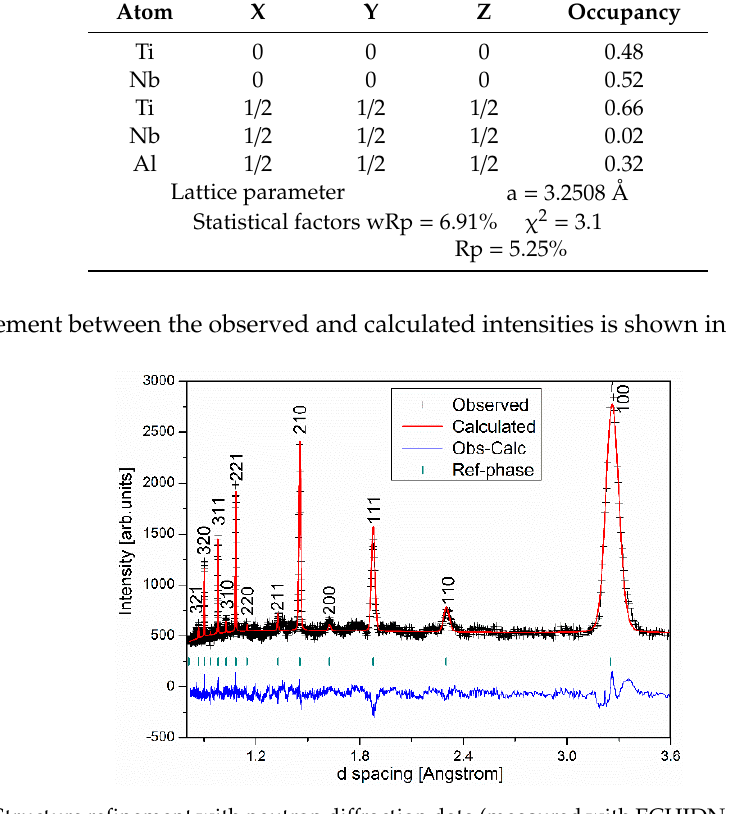
Figure 3. Structure refinement with neutron diffraction data (measured with ECHIDNA diffractometer).